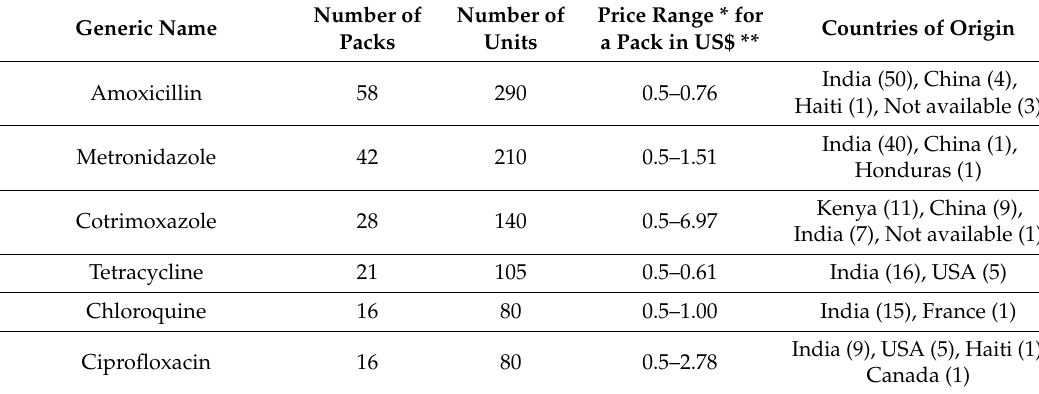
Table 1. Description of the 196 packs and 975 units acquired in the selected street markets of Port-au-Prince (Haiti) used for the analyses conducted in the present study (see Methods). The table also includes the price range (in US$) of the di ff erent products and the countries of origin of each